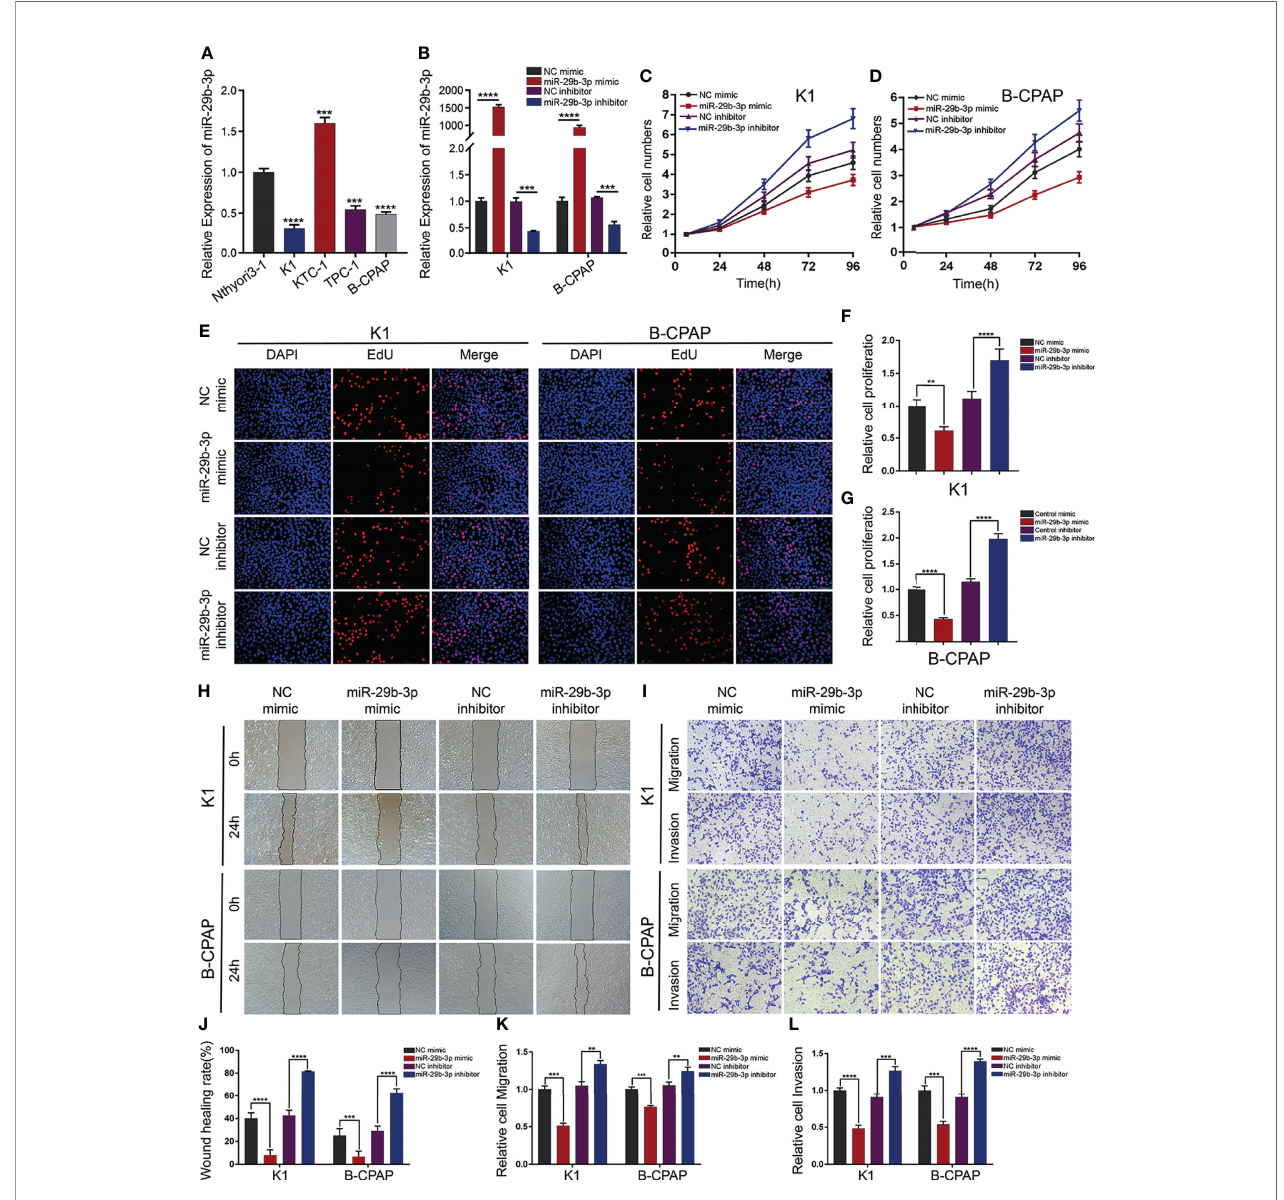
FIGURE 2 | miR-29b-3p inhibits PTC cell migration and invasion in vitro . (A) Expression of miR-29b-3p was veri fi ed by qRT-PCR in PTC cell lines (K1, KTC-1, TPC-1, and B-CPAP) and normal thyroid cell lines (Nthyori3 – 1); two lowly expressing (K1 and B-CPAP) cell lines were selected for further study. (B) The knockdown and overexpression ef fi ciencies of miR-29b-3p was veri fi ed by qRT-PCR after transfection with miR-29b-3p mimic/inhibitor or NC mimic/inhibitor. Cell proliferation ability of PTC cells was determined by CCK-8 assays (C, D) and EdU assays (E – G) after miR-29b-3p overexpression or knockdown. The effects of miR-29b-3p overexpression and knockdown in PTC cells on cell migration and invasion were analyzed by wound healing assays (H) and Transwell assays (I) . (J, L) Results of the Transwell assays and wound healing assays. In the fi gure,**p < 0.01, ***p < 0.001,****p <